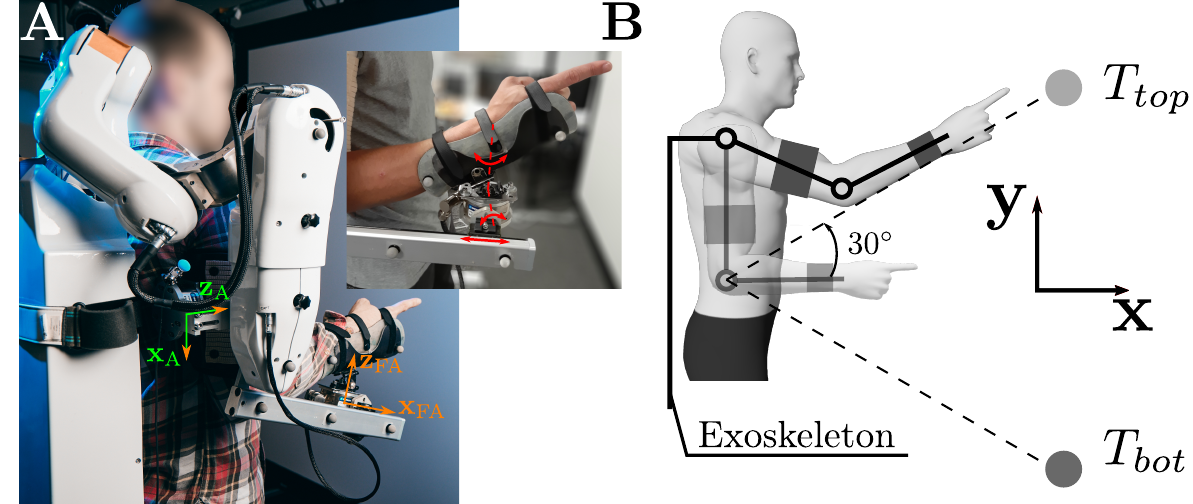
Figure 1. Illustration of the task. ( A ) Posture of a participant inside the exoskeleton. The axes ( x A and z A ) of the arm force sensor are highlighted in green. The last axis y A of the arm force sensor was defined by y A = z A × x A . The same definitions were adopted for the forearm force sensor, with axes represented in orange. The passive rotations and translation are illustrated in red in the zoomed picture. ( B ) Schematic representation of the task and the target location. The reference position is